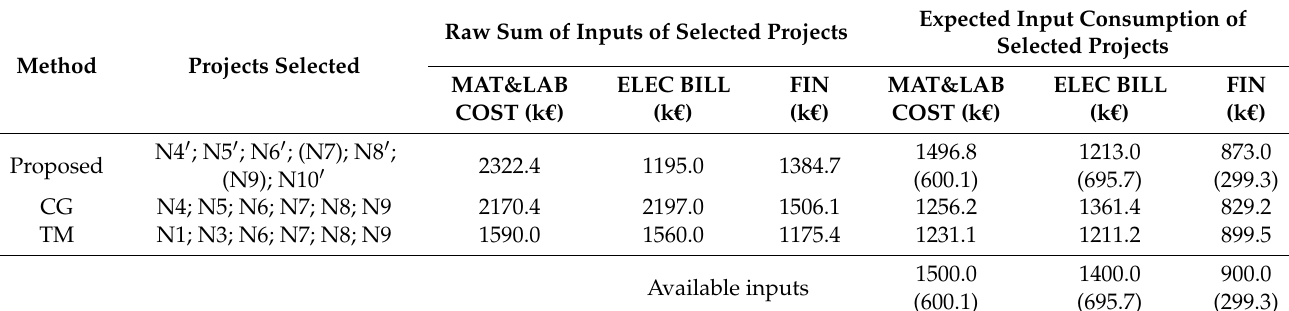
Table 4. Sum of inputs and expected inputs of selected projects in the solution of the different